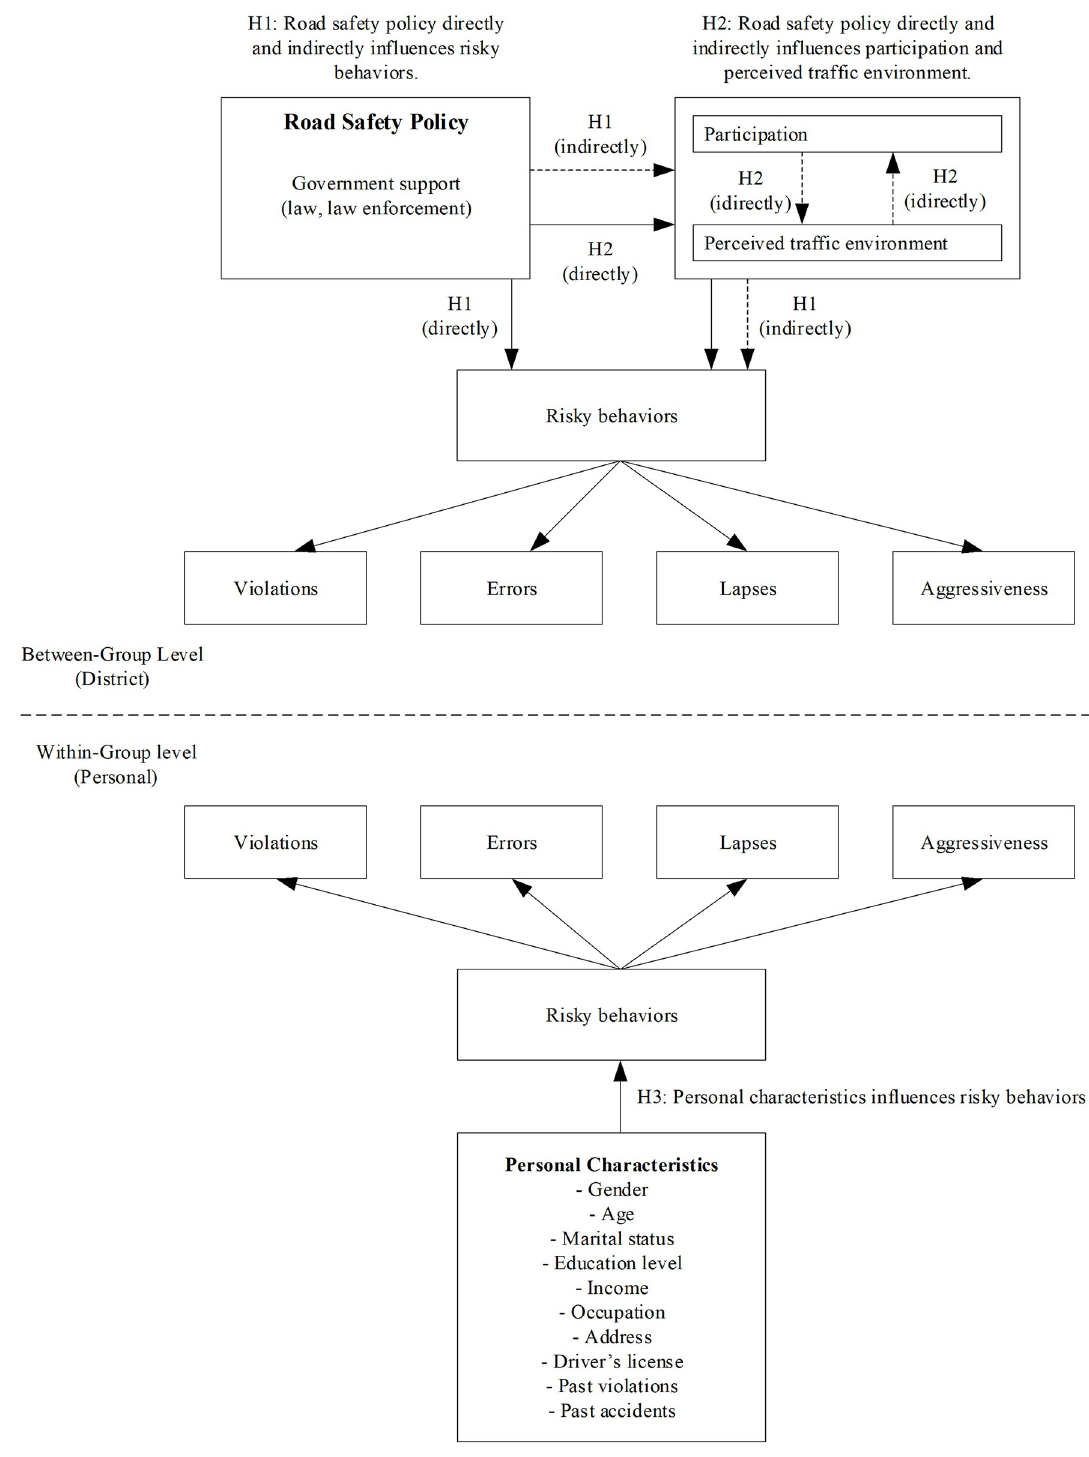
Fig 1. Analytical